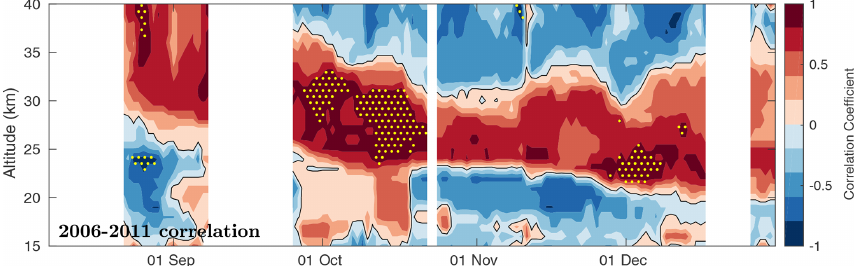
Figure 11. Correlation between (cid:99) Ap and area-weighted polar MIPAS ClONO 2 for the 2006–2011 period. The y axis is the altitude from 15 to 40km, and the x axis is the date from early August until the end of December. The coloured contours indicate the correlation coefficient with a contour interval of 0.2, and the black contour is the zero contour. Stippling indicates statistical